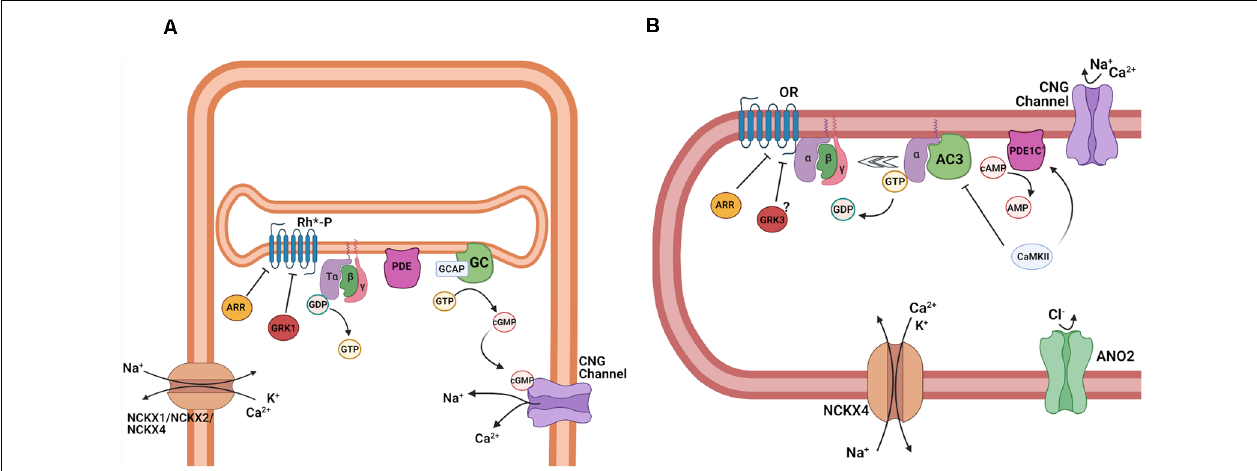
FIGURE 5 | Termination of transduction cascade in rod photoreceptors and OSNs. (A) Schematic representation of the termination of phototransduction in rods. Abbreviations: Phosphorylated light-activated rhodopsin (Rh*-P), arrestin (ARR), G protein-coupled receptor kinase 1 (GRK1), T α , β , and γ subunits of the retinal G protein, transducin (T), guanosine-5 (cid:48) -triphosphate (GTP), guanosine-5 (cid:48) -diphosphate (GDP), phosphodiesterase (PDE), guanosine monophosphate (GMP) and cyclic guanosine monophosphate (cGMP), and cyclic nucleotide-gated (CNG) channel, guanylate cyclase (GC), guanylate cyclase activating protein (GCAP), cyclic nucleotide-gated (CNG) channels, K + dependent Na + /Ca 2+ exchanger 1, 2 and 4 (NCKX1, NCKX2, NCKX4). (B) Schematic representation of the termination of the olfactory transduction cascade. Abbreviations: Olfactory receptor (OR), arrestin (ARR), G protein-coupled receptor kinase 3 (GRK3) G α olf , β , and γ , subunits of the olfactory G protein, guanosine-5 (cid:48) -triphosphate (GTP), guanosine-5 (cid:48) -diphosphate (GDP), adenylyl cyclase 3 (AC3), activated phosphodiesterase 1C (PDE1C), cyclic adenosine monophosphate (cAMP), adenosine monophosphate (AMP), Ca 2+ /calmodulin-dependent protein kinase II (CaMKII), cyclic nucleotide-gated channel (CNG); Ca 2+ -activated Cl − channel anoctamin 2 (ANO2), K + -dependent Na + /Ca 2+ exchanger 4 (NCKX4). Images created with BioRender.com.